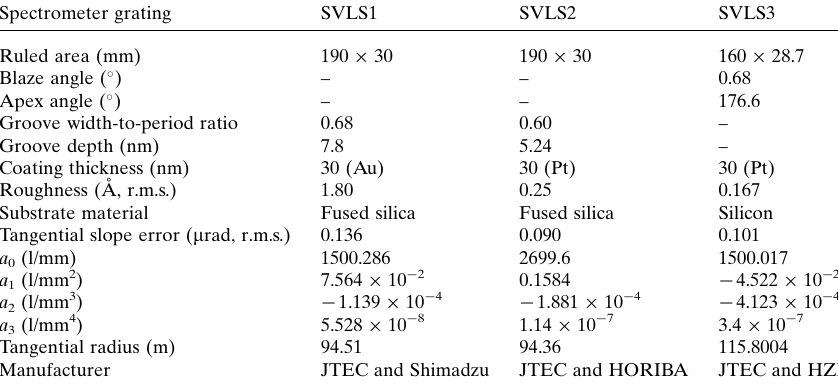
Table 5 List of all gratings in the I21 SGM after the sample position. Spectrometer grating SVLS1 SVLS2 SVLS3 Ruled area